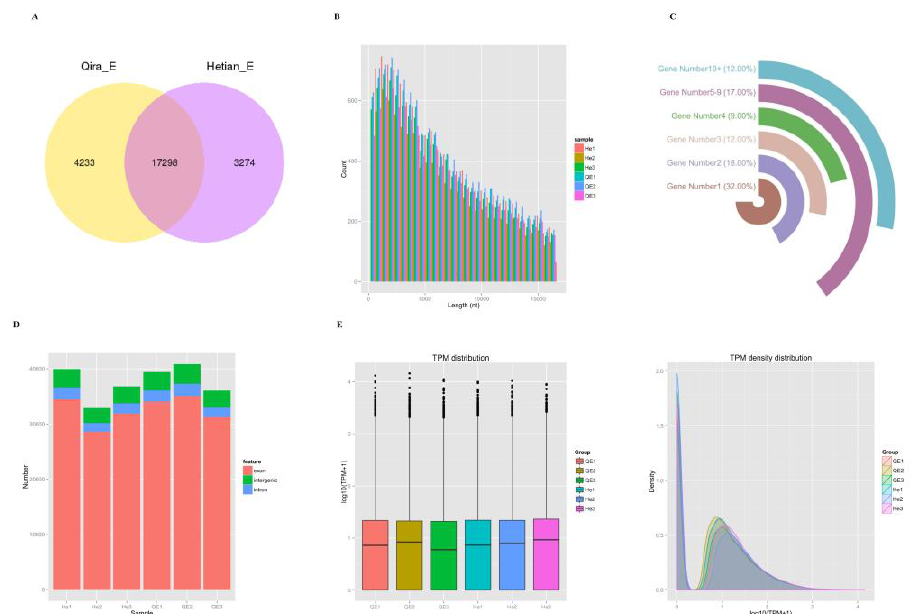
Figure 1. General characteristics of circRNAs in sheep ovaries. ( A ) Venn diagram of circRNA. ( B ) Length distribution of circRNA in sheep ovaries. ( C ) Distribution of circRNA host genes. More than 30% of host genes (1608) produce one circRNA, 918 host genes produce two circRNAs, and 506 host genes produce more than 10 circRNAs. ( D ) Distribution of circRNA genomic regions. ( E ) The expression of circRNAs in each sample was counted and normalized using TPM.